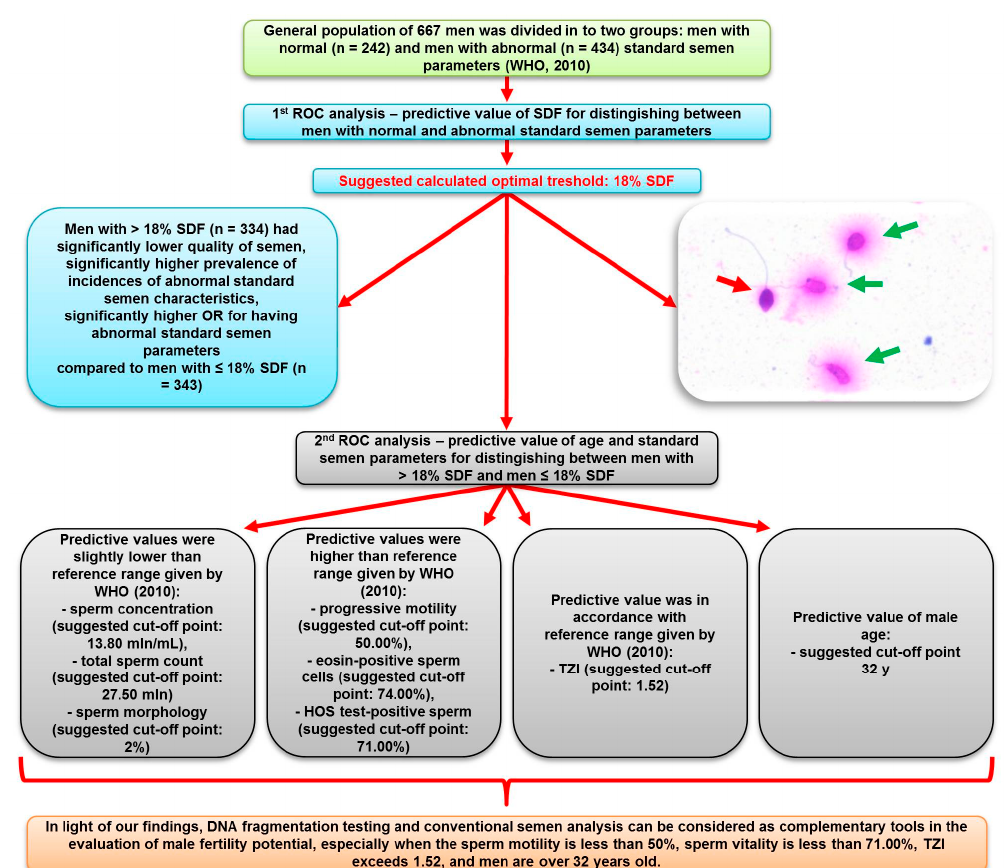
Figure 2. Scheme illustrating strategy developed in study analyses. ROC—receiver operating characteristic; SDF—sperm DNA fragmentation; OR—odds ratio; TZI—teratozoospermia index. Insert—visualization of sperm chromatin dispersion measured by Halo Sperm test. Spermatozoa with a big halo were considered as cells without SDF (green arrows), while those with a small halo were considered as cells with SDF (red arrow) (details in